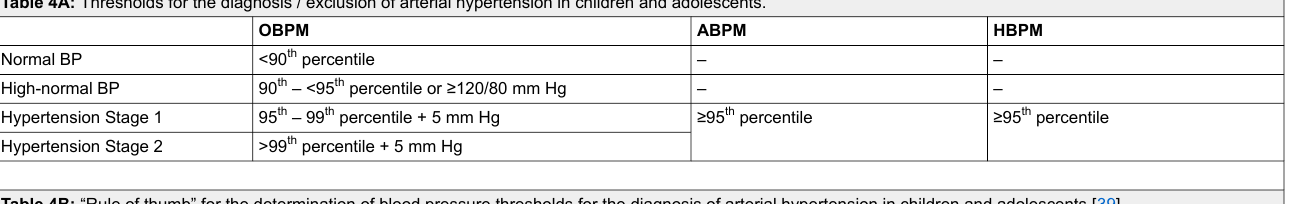
Table 4B: “Rule of thumb” for the determination of blood pressure thresholds for the diagnosis of arterial hypertension in children and adolescents [39]. Age (years) Systolic